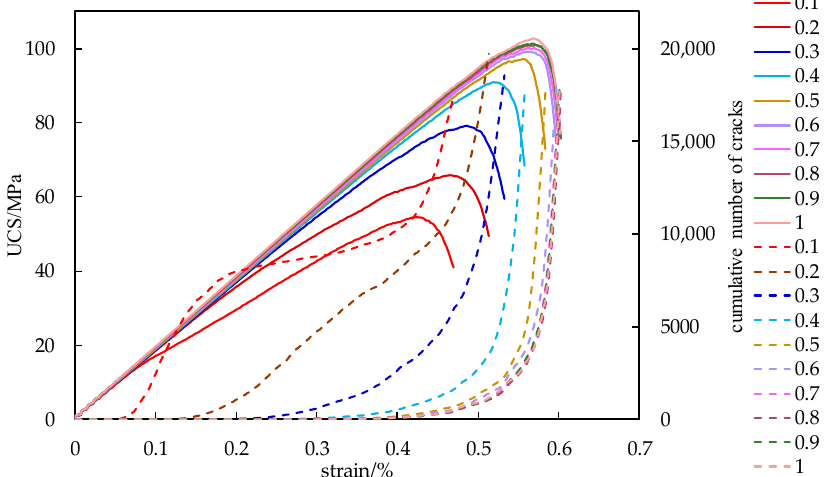
Figure 4. Accumulated cracks and stress–strain curves under different cementation strength ratios .